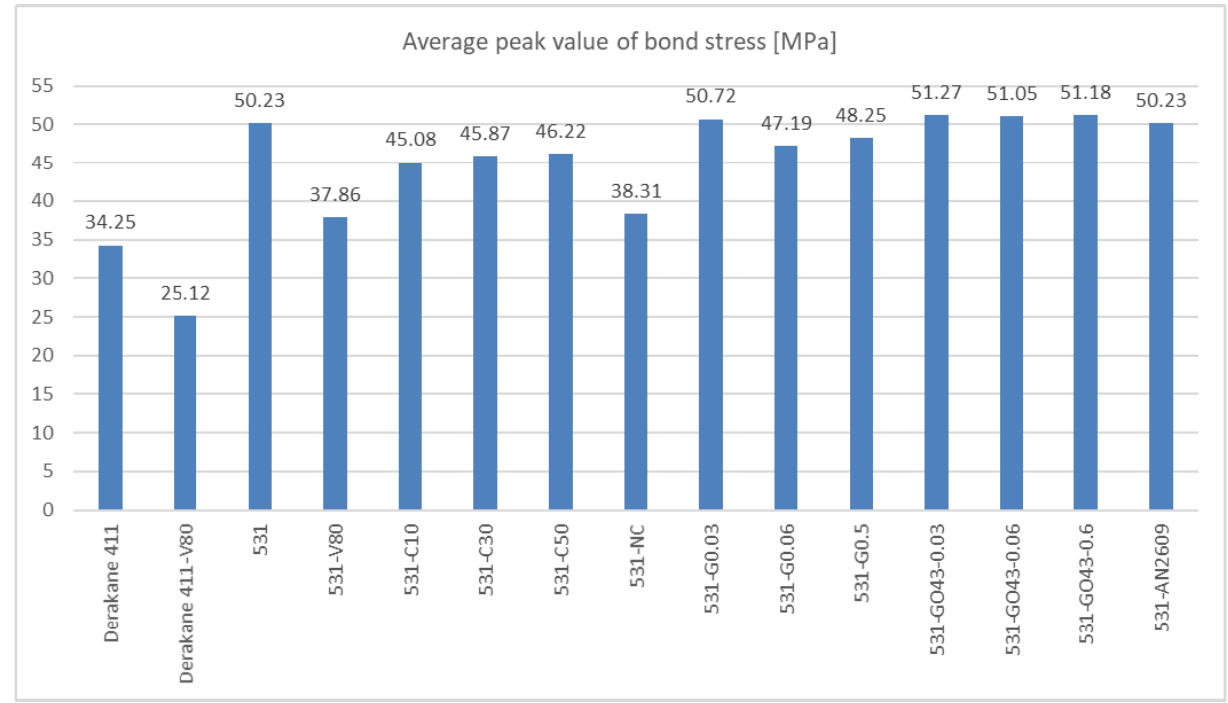
Figure 20. A comparison of average value of peak bond strength of the tested